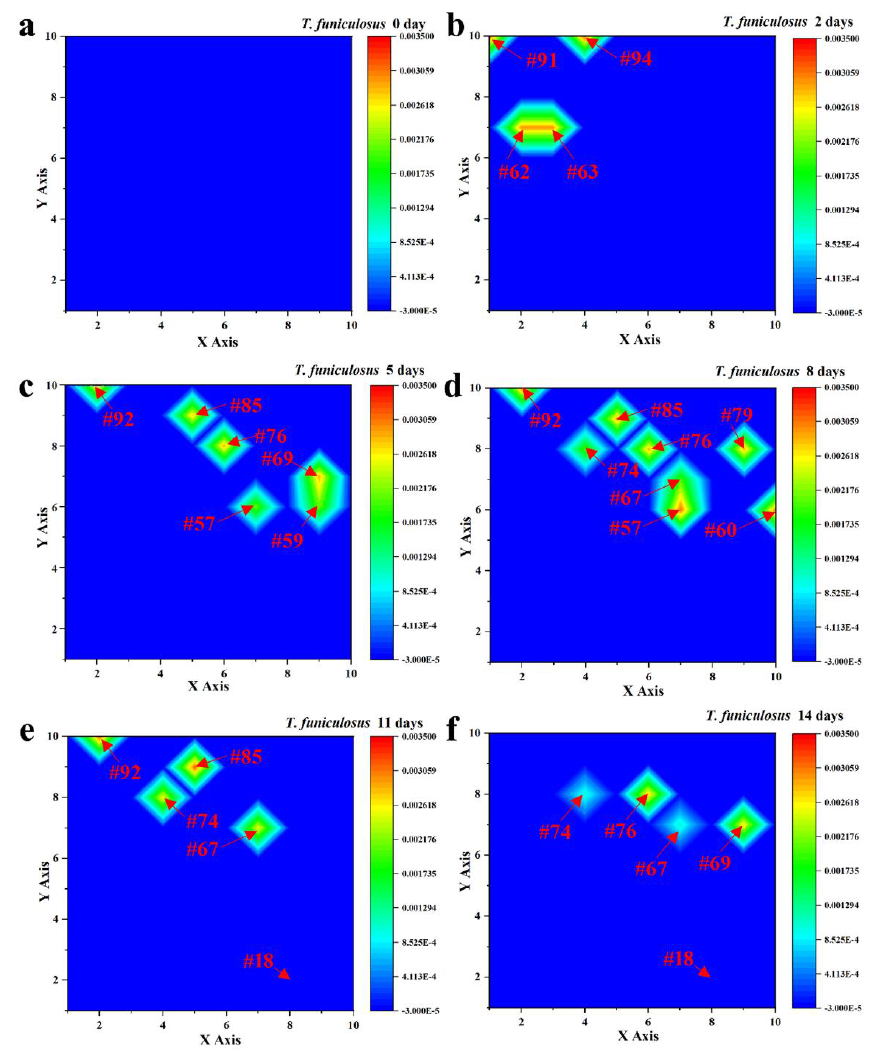
Figure 4. Current density distribution of the entire WBE surface after the immersion in the T. funiculosus -contained medium for 0 days ( a ), 2 days ( b ), 5 days ( c ), 8 days ( d ), 11 days ( e ), and 14 days ( f ).